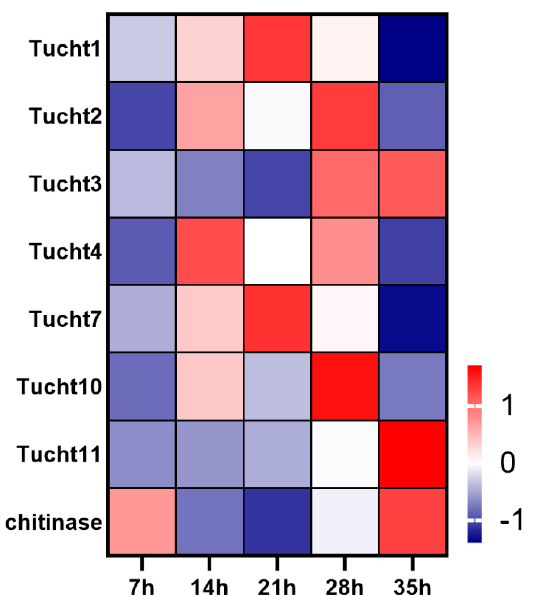
Figure 6. Expression profiles of chitinase genes during developmental process of deutonymph in T. urticae . The color scales represent the values were normalized by Z-score ((value-mean value)/stand- T. urticae ard error) for each development time point.